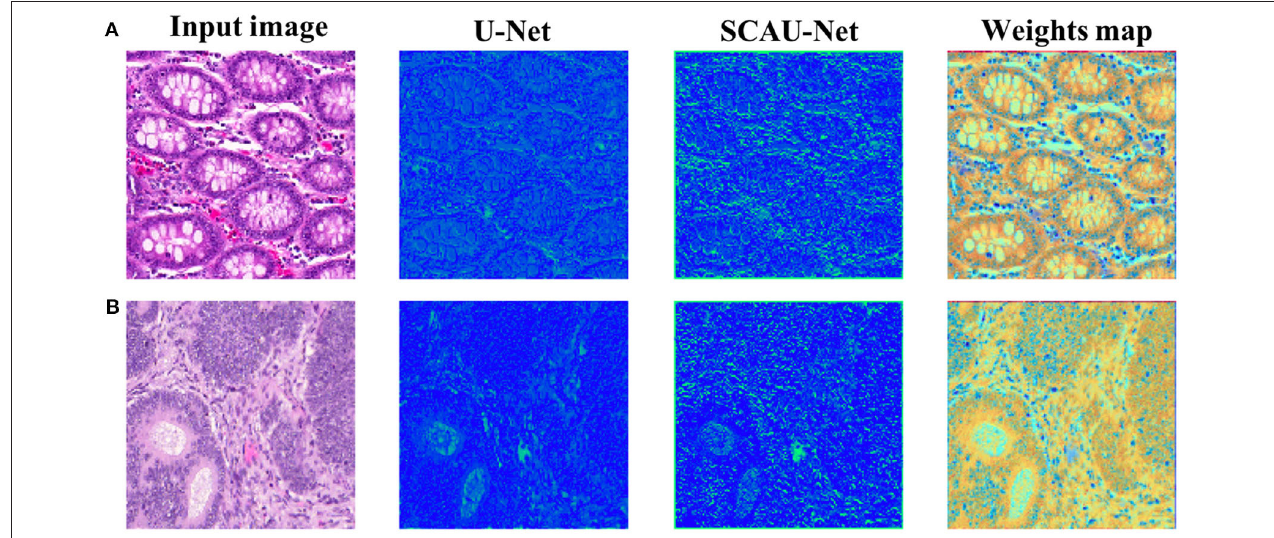
FIGURE 6 | Visualization the output feature activations after Block(64). Compared with the basic U-Net network, SCAU-Net exploits spatial attention weights to recalibrate the feature map. Weights map by SCAU-Net is shown in the last column. Examples (A,B) are from the GlaS